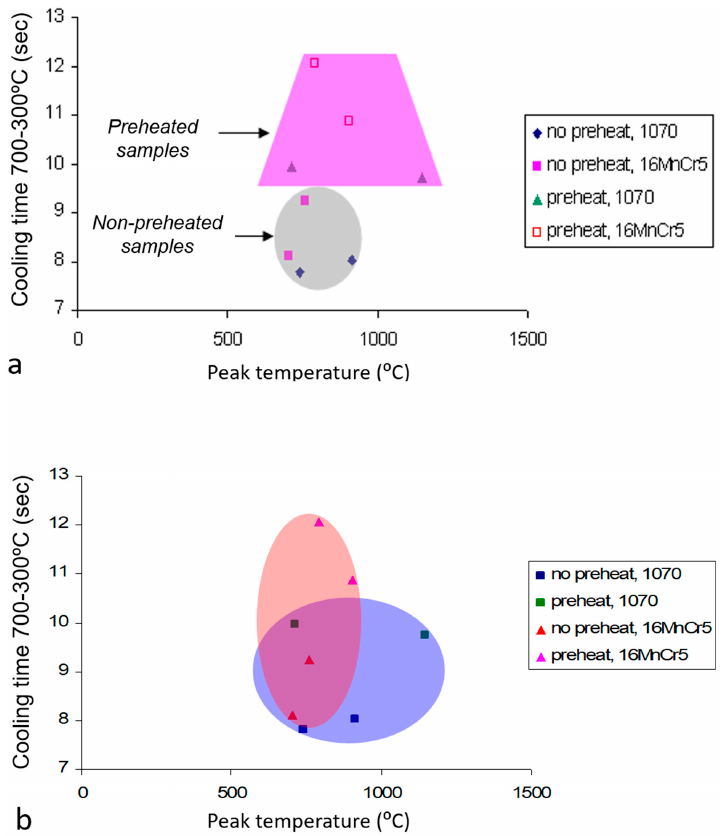
Figure 13. Effect of ( a ) the preheating and ( b ) material type on cooling